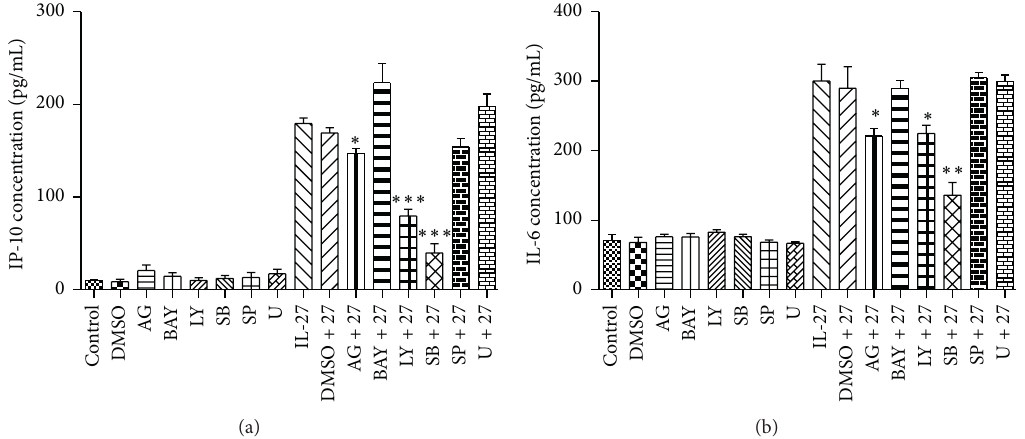
Figure 5: The signaling molecule inhibitors affect the production of CXCL10 and IL-6 in HTR-8/SVneo. Analysis of the effects of AG, BAY, LY, SB, SP, or U on IL-27 induced CXCL10 and IL-6 release determined by enzyme-linked immunosorbent assay. HTR-8/SVneo cells were pretreated with AG490 (9 VM; AG), BAY1167082 (0.9 VM; BAY), LY294002 (8.4 VM; LY), SB203580 (36 VM; SB), SP600125 (7 VM; SP), or U0126 (20 VM; U) for 1h followed by incubation for a further 24 h or 48 h with or without IL-27 (50ng/mL). DMSO (0.1%) was used as the vehicle control. Results are expressed as the arithmetic mean ± SD from three independent experiments. ∗ 𝑃 < 0.05 and ∗∗∗ 𝑃 < 0.001 when compared between groups denoted by horizontal